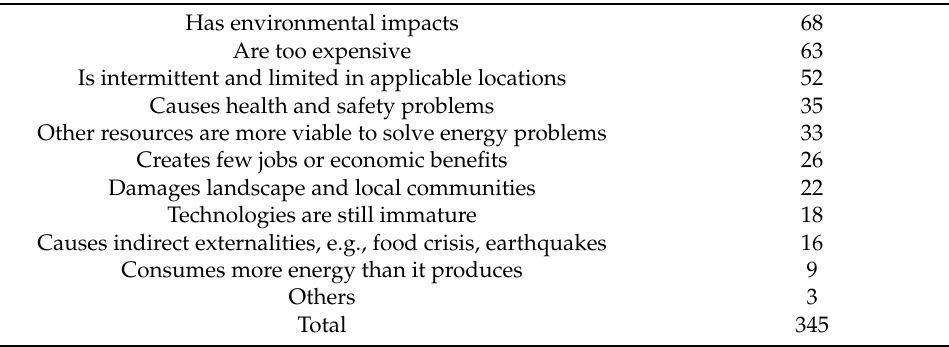
Table 1. Results of most common public concerns on renewable